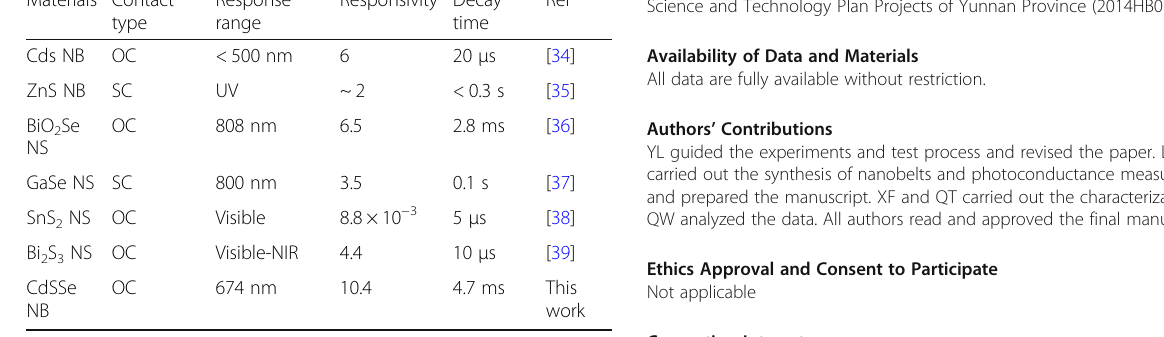
Table 1 Comparisons of important parameters of photodetectors based on single different nanobelt/nanosheet Materials Contact Response type